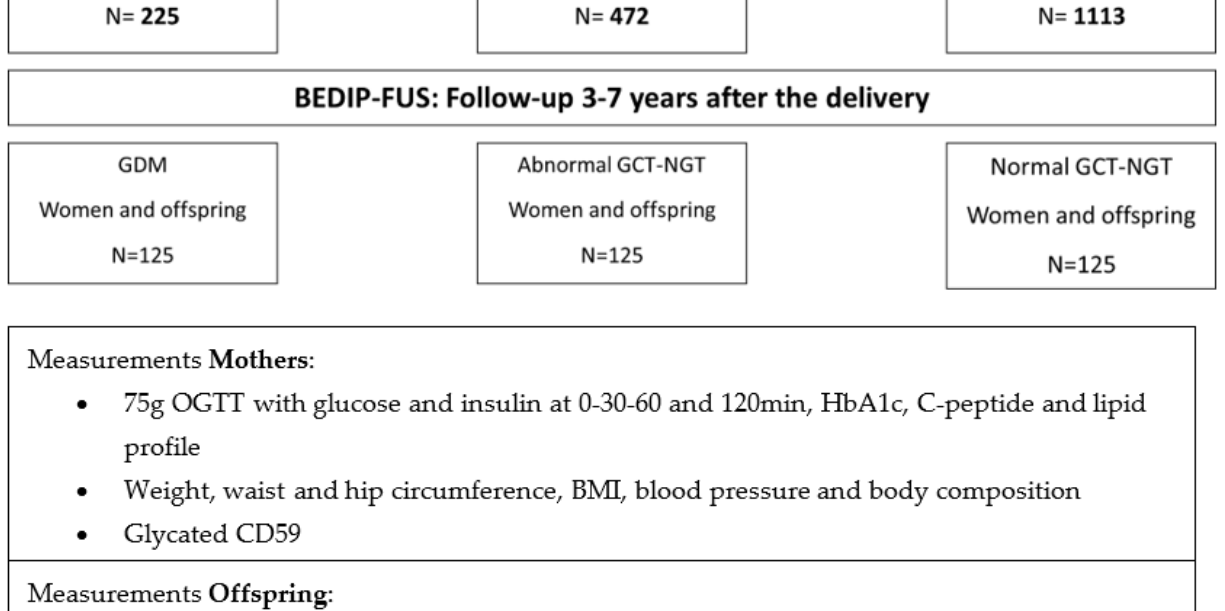
Figure 1. Study flowchart. BEDIP: Belgian Diabetes in Pregnancy; GDM: gestational diabetes mellitus; GCT: glucose challenge test; NGT: normal glucose tolerant (=normal OGTT); BEDIP-FUS: BEDIP follow-up; OGTT: oral glucose tolerance test; min: minutes; HbA1c: hemoglobin A1c; BMI: body mass index.